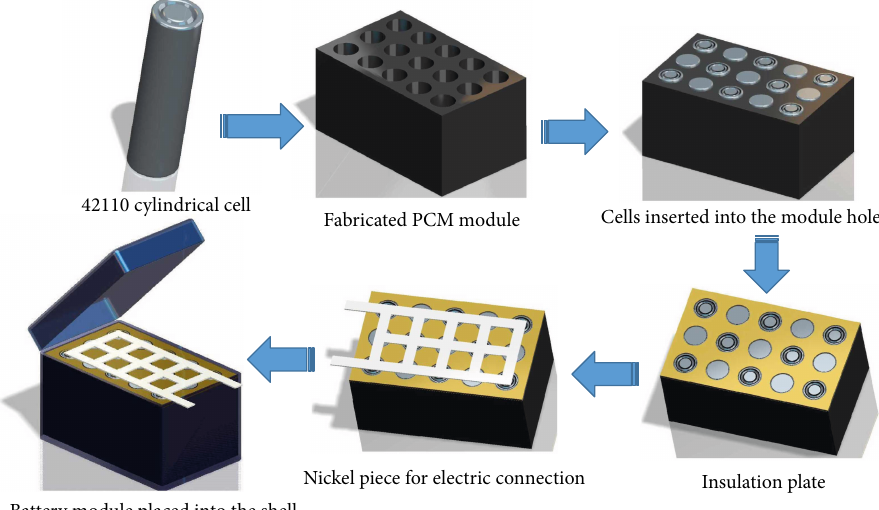
Figure 2: The battery module assembly process.